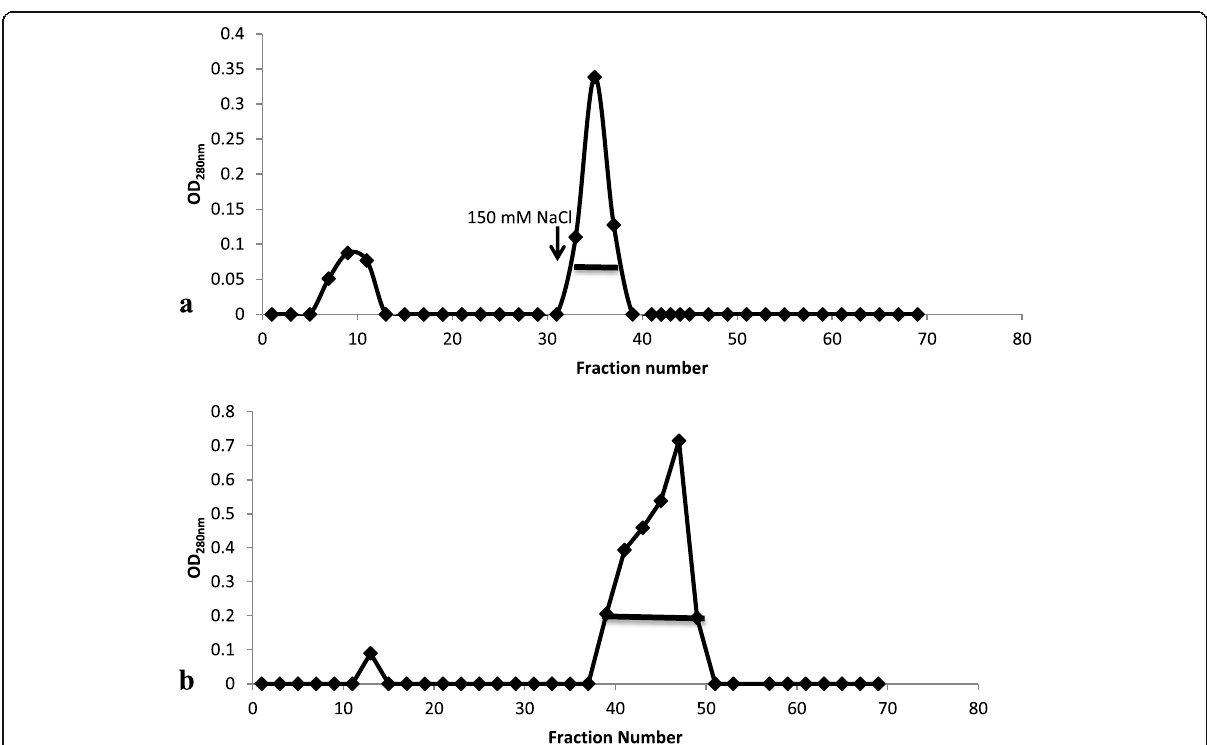
Fig. 2 Column chromatography profile of Dioscorea bulbifera. a Ion-exchange chromatography of dialyzed 70% ammonium sulphate precipitate of the extract of the aerial tuber of Dioscorea bulbifera on DEAE Sephadex A-25 column (elution buffer: 0.05 M Tris-HCl buffer pH 8.3. Adsorbed protein was eluted with 0.05 M Tris-HCl buffer pH 8.3, containing 150 mM NaCl). Column size (1.5 × 20) cm; flow rate 15 ml/h; fraction size 5 ml. b Gel filtration of adsorbed peak from ion-exchange on Sephadex G-75 column (elution buffer: 100 mM Tris-HCl pH 7.9 with 100 mM NaCl). Column size (1.5 × 40) cm; flow rate 27 ml/h; fraction size 3.6